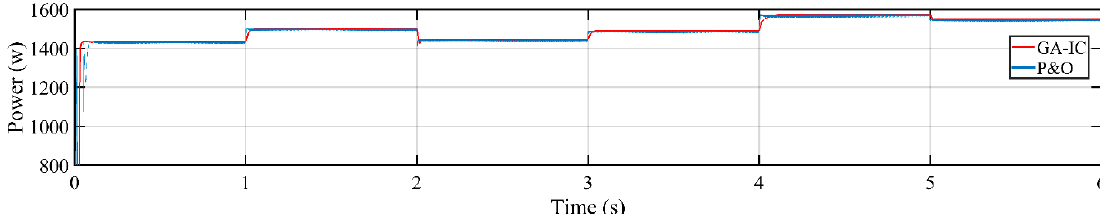
Figure 33. Case 3 power, detailed comparison of modified GA-IC vs. P&O.